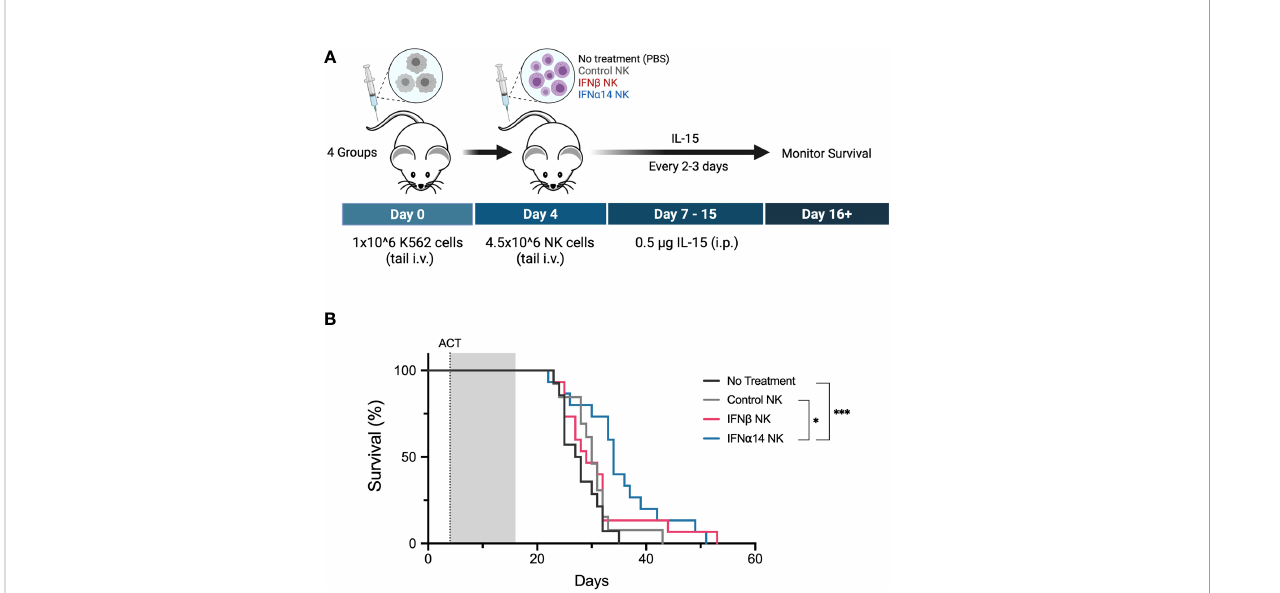
FIGURE 6 Activation with IFN a 14, but not IFN b , enhances NK cell antitumor responses against K562 leukaemia in vivo in NSG mice (A) Experimental design. Day 0: NSG mice received 1 x 10 6 K562 cells via tail vein injection. Day 4: NSG mice received 200 µL PBS (no treatment) or 4.5 x 10 6 14- day-expanded NK cells (control NK, IFN b NK, IFN a 14 NK) via tail vein injection. IL-15 (0.5 µg) was administered on day 0 and every 2-3 days thereafter until day 15. (B) Kaplan-Meier curves summarize the survival of mice treated. A total of 13-15 mice were used per group, and each experiment was performed independently three times. Groups were compared using the log-rank (Mantel-Cox) test. * p < 0.05, *** p <